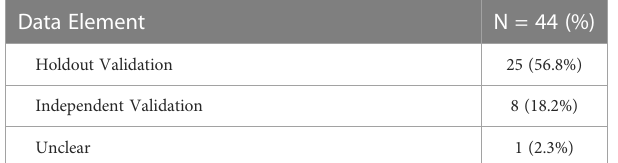
TABLE 3 Descriptive statistics related to type of study and NLP usage, source and size of datasets, and model